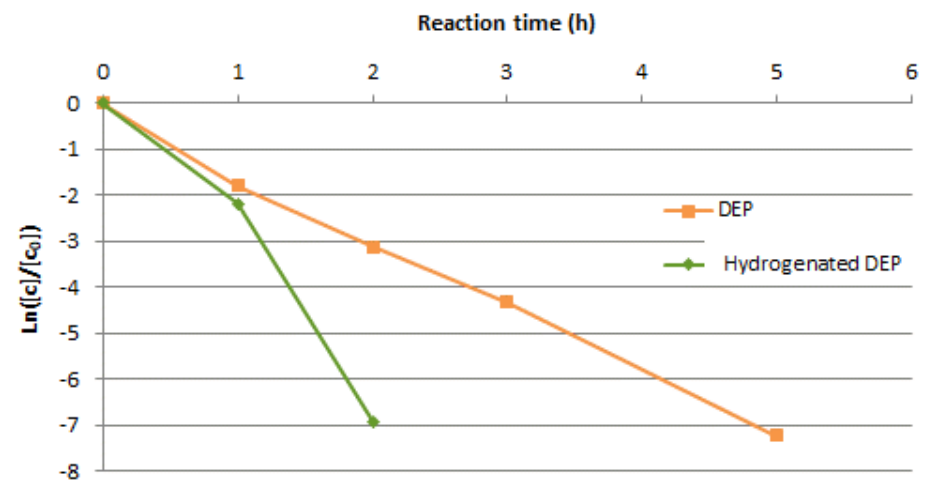
Figure 6. Photodegradation of diethyl phthalate and pre-hydrogenated diethyl phthalate in aqueous solution in the presence of Rh 0 NPs@TiO 2 . The reaction conditions were as follows: T = 20 ◦ C, C 0 = 222 mg · L − 1 , unregulated pH and an incident light flux of 16 W · m − 2 .